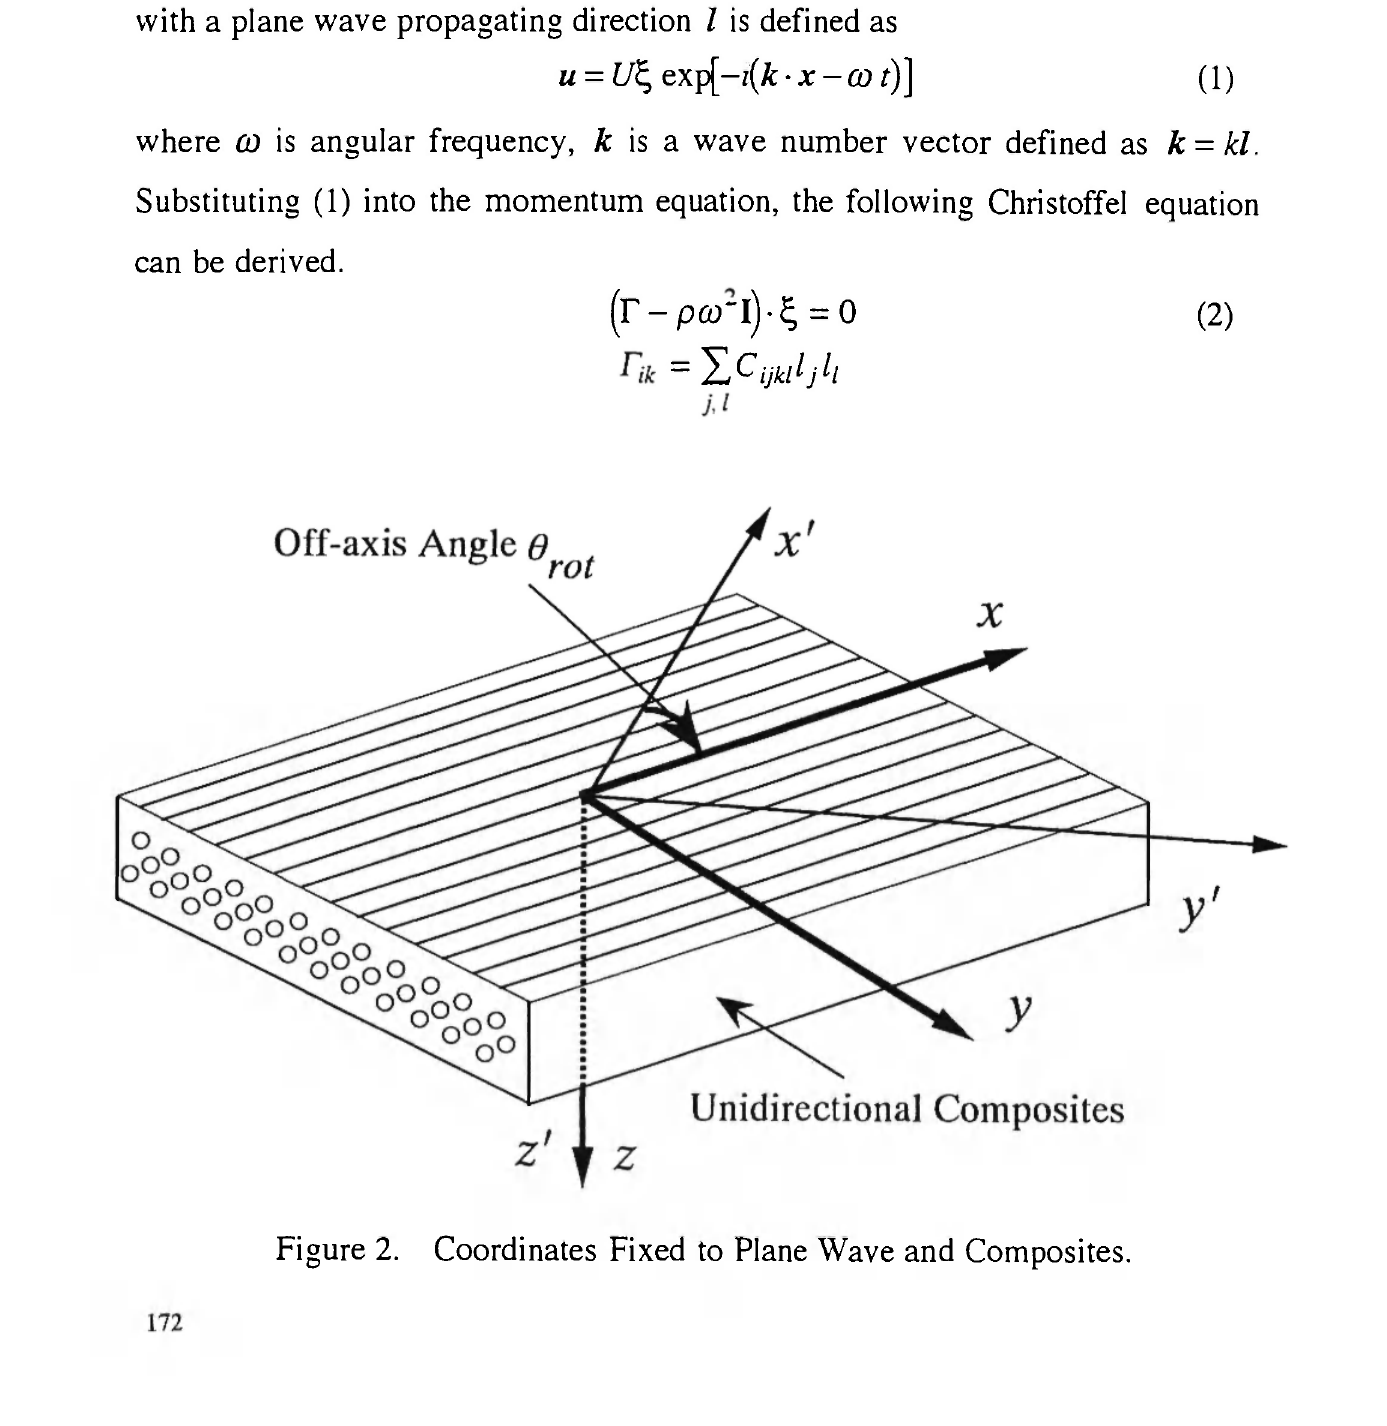
Figure 2. Coordinates Fixed to Plane Wave and